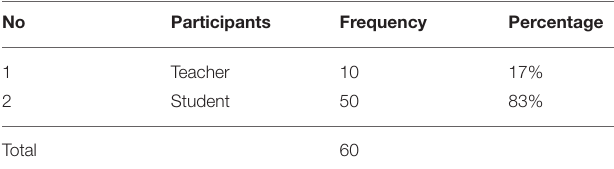
TABLE 2 | The characteristics of research participants. TABLE 3 | The tolerance value